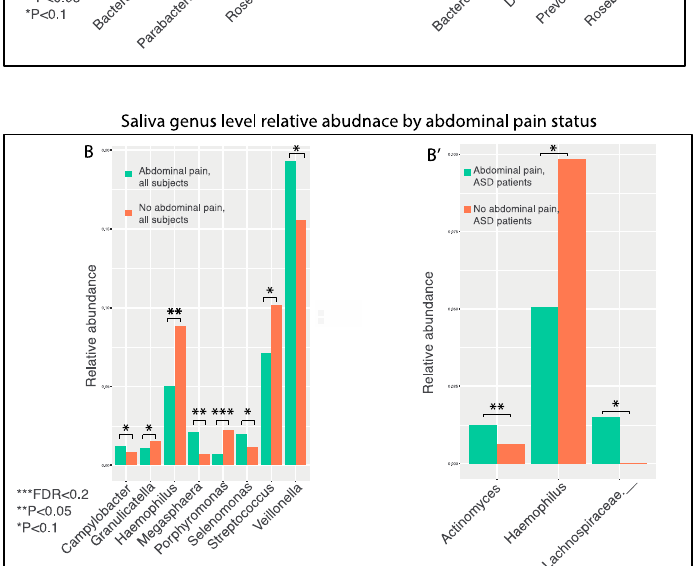
Figure 7. Bar plot representation of the relative abundances of gut ( A – A’ ) and oral ( B – B’ ) bacterial genera correlating with the abdominal status of the subjects enrolled in this study. ( A ) The most differentially abundant gut genera in all subjects with no abdominal pain and those with abdominal pain; ( A’ ) The most differentially abundant gut genera in ASD patients with no abdominal pain and patients with abdominal pain. ( B ) The most differentially abundant oral genera in all subjects with no abdominal pain and those with abdominal pain; ( B’ ) The most differentially abundant oral genera in ASD patients with no abdominal pain and patients with abdominal pain. Single asterisk indicates p < 0.1; double asterisk indicates p < 0.05, Kruskal–Wallis test.